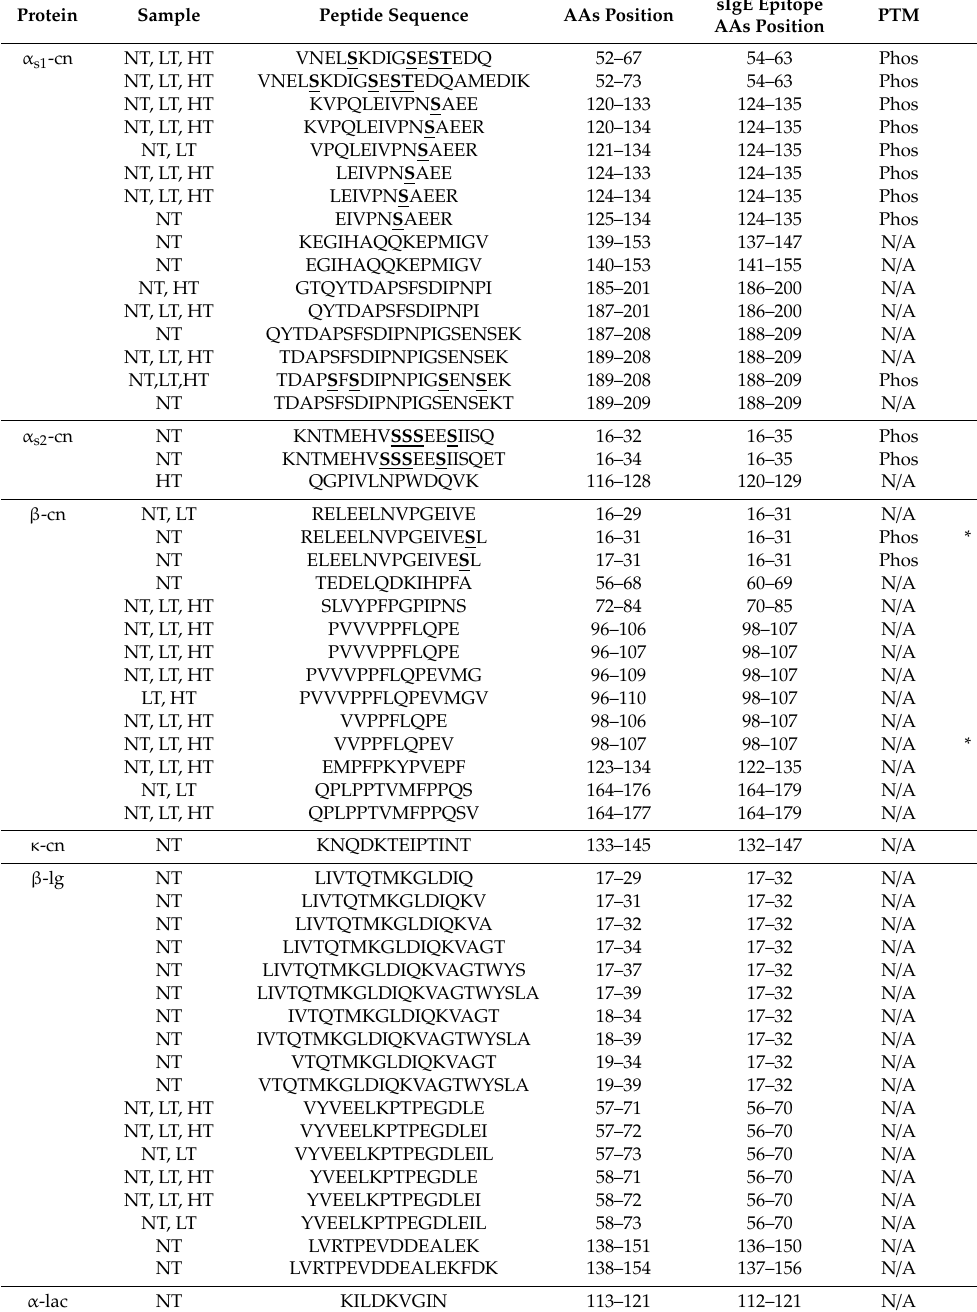
Table 1. sIgE binding epitopes 1 identified in digestion-derived peptides after 10 min in the intestinal phase. Peptides were identified in cow’s milk protein, non-treated (NT), heated at low temperature (LT), and heated at high temperature (HT), after simulated infant in vitro digestion and derived from casein (cn), β -lactoglobulin (lg), and α -lactalbumin (lac). Peptides matching exactly the sIgE binding epitope sequence are indicated (*). Amino acids (AAs) position indicates the position within the proteins including the signal peptide. Peptides carrying a post translational modifications (PTM) are marked with phosphorylation (Phos), whereas phosphorylated serine (S) and threonine (T) residues are highlighted in bold and